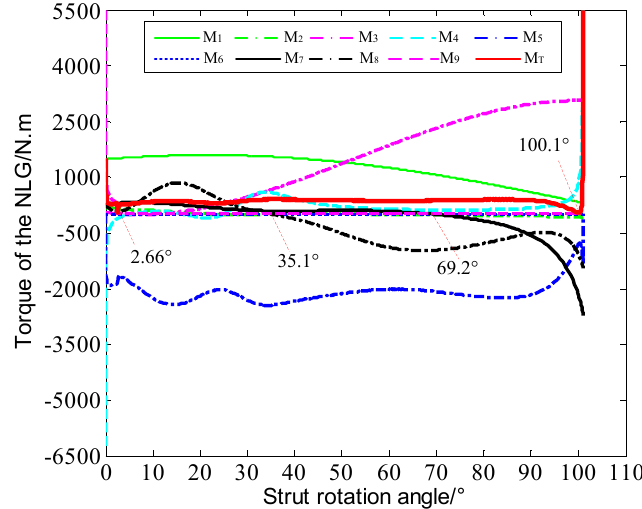
Figure 3. Change of NLG torques with strut rotation angle at 270Kts.